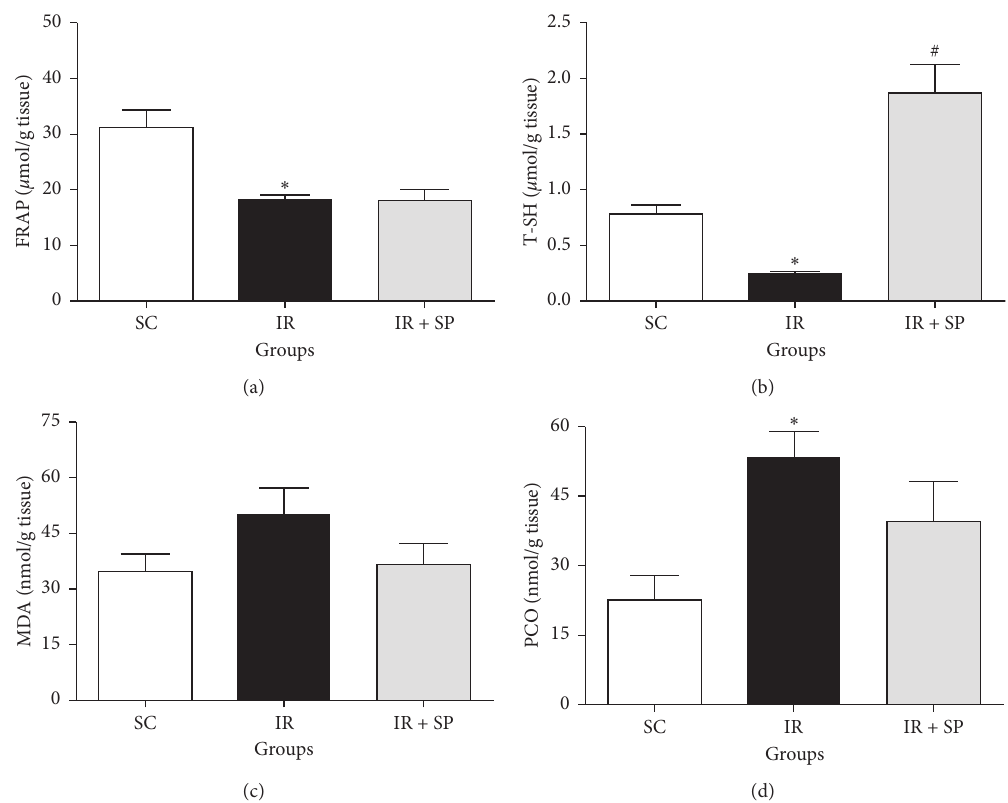
Figure 4: Effect of SP extract on FRAP (a), T-SH (b), MDA (c), and PCO (d) following I/R injury. Data are shown as mean ± SEM. ∗ Significant against the SC rats ( P < 0 . 05); # significant against the I/R group ( P < 0 . 05). SC: sham control; SP : Stachys pilifera ; I/R: ischemia- reperfusion; FRAP: ferric reducing antioxidant power; PCO: protein carbonyl; T-SH: total thiol; MDA: